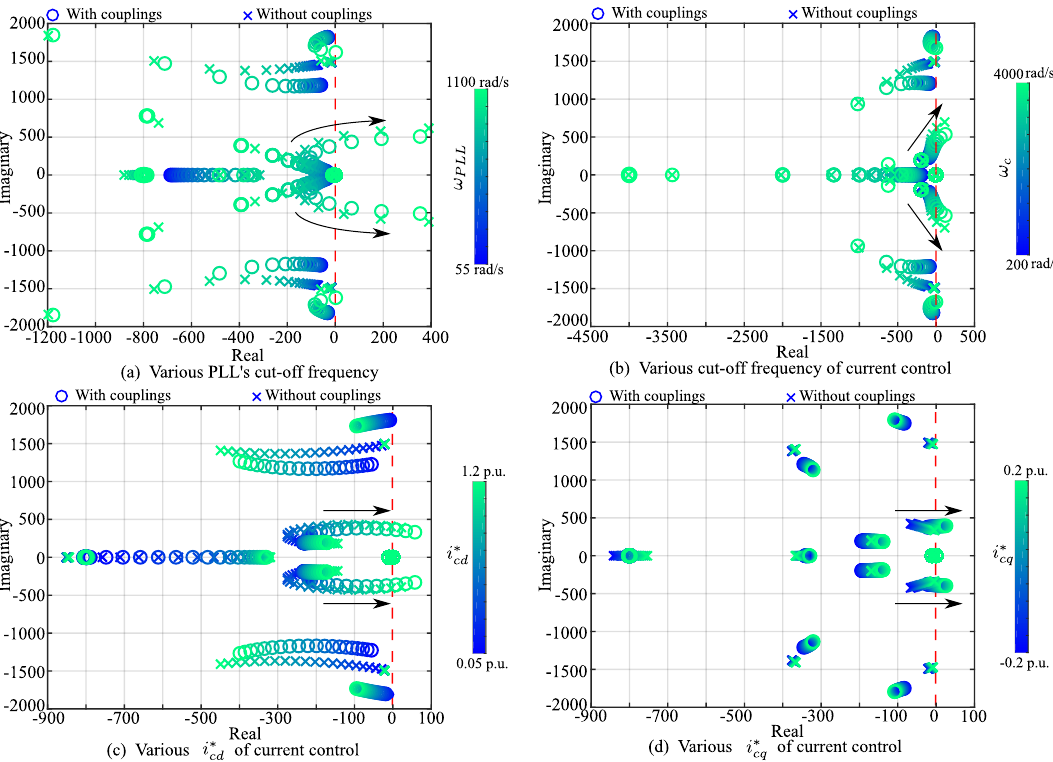
Figure 5. Pole locus: determinant-based impedance stability analysis vs. eigenvalue-based impedance stability